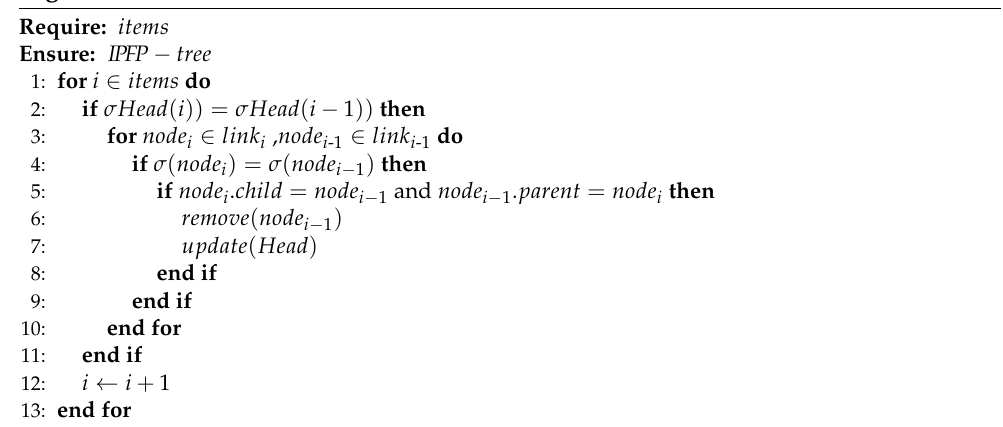
Algorithm 2 IPFP Tree